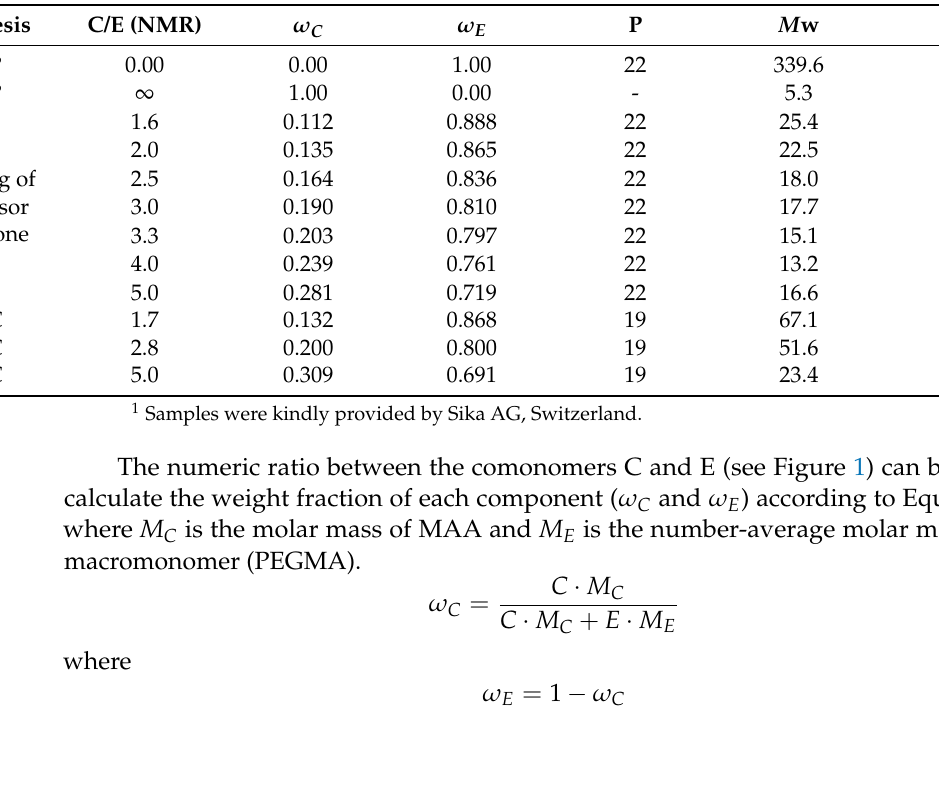
Table 1. Average molecular characteristics of applied PCEs. The numeric ratio between the comonomers (C/E) was obtained from 1 H-NMR spectroscopy. The corresponding weight fractions of component C and E were calculated according to Equation (1). P gives the number of repeating units in the PEG side chain. M w and the dispersity index, Ð, were measured via SEC using online refractive index and MALLS